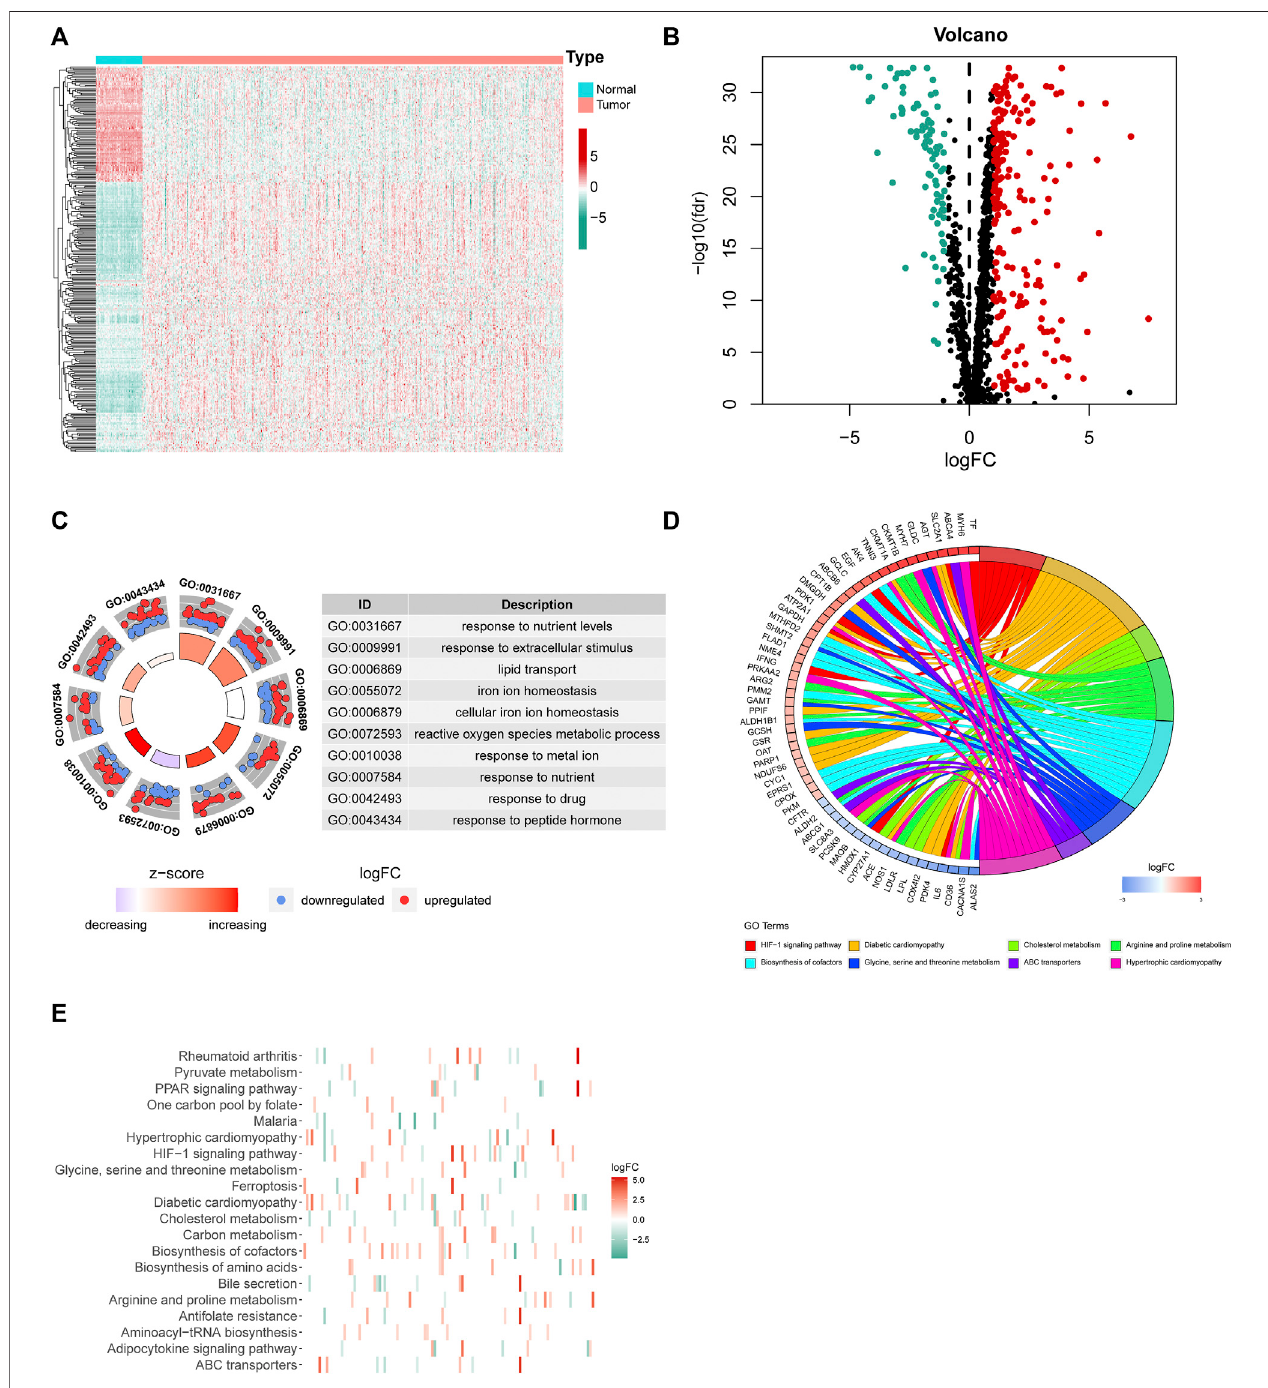
FIGURE2| Differentialexpressionanalysisandcorrespondingfunctionalenrichmentofthe1,499MHRGs. (A) Aheatmapofthe294differentiallyexpressedgenes. (B) A volcano plot based on the 205 upregulated and 89 downregulated genes. (C) The most highly signi fi cant 10 results in the GO analysis. (D,E) The corresponding genes and the distribution of enriched biological pathways in the KEGG analysis.